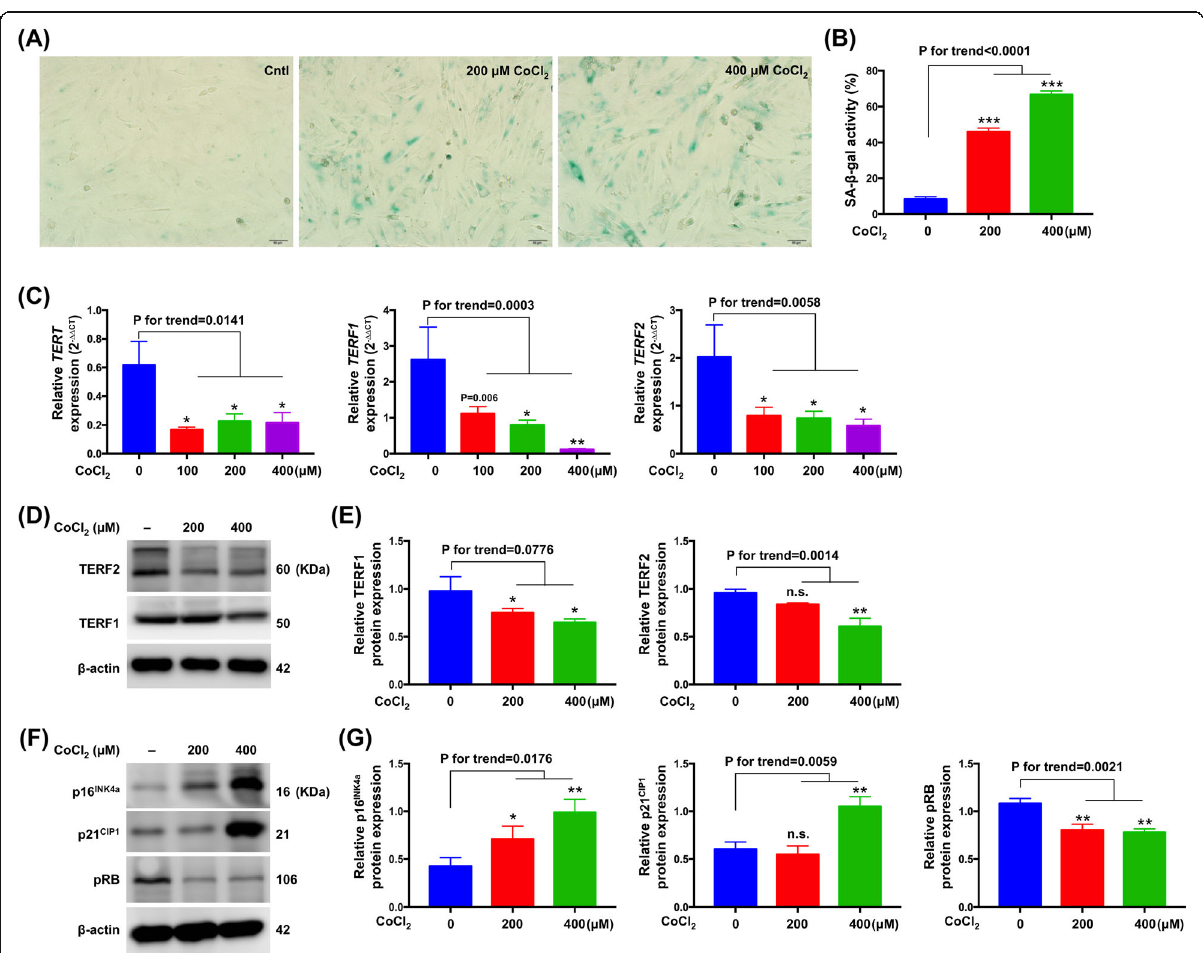
Fig. 2 CoCl 2 in rat vascular smooth muscle cells (A7r5) inhibited proliferation and induces senescence. a Senescence-associated- β -galactosidase staining demonstrating senescence in CoCl 2 and medium treated cells. b Bar graphs show quantification of relative of SA- β -gal positive cells ( n = 3). c mRNA expressions of TERT, TERF1 and TERF2 compared in cells treated with CoCl 2 or medium only (n=3). d , f Representative western blots depicting TERF1, TERF2, p16 INK4 , p21 CIP1 , pRB expression in CoCl 2 and medium treated cells. e , g Normalized expressions of TERF1, TERF2, p16 INK4 , p21 CIP1 , pRB ( n =3). Data are presented as the means±SEM.* P <0.05; ** P <0.01; *** P <0.001; ns, non-significance (one-way ANOVA with Tukey-Kramer post hoc